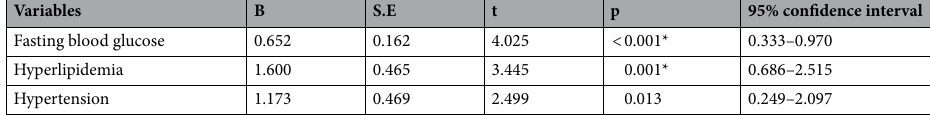
Table 2. The results of Stepwise linear regression analysis (take obesity as the dependent variable). *Means p < 0.05.